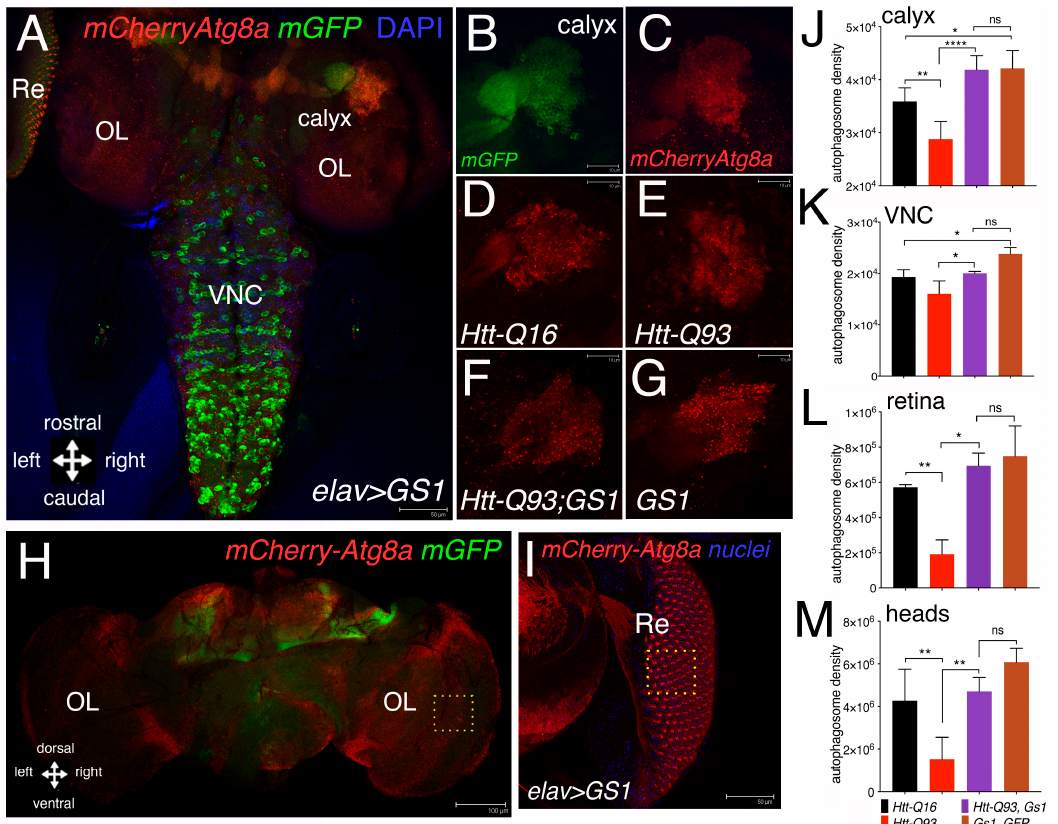
Figure 4. Expression of GS1 in neurons induces autophagy. ( A ) Confocal image of whole the brain from a third instar larva showing the pattern of expression for elav-mCherryAtg8a; GFP where the autophagic puncta are marked in red and neurons by GFP; the images represent the pattern of expression of elav-mCherryAtg8a from animals expressing UAS-GS1 . ( B , C ) Insets showing a higher magnification of the right calyx from A; neurons are visualized by elav-GFP. ( B ) and autophagic puncta by elav - mCherryAtg8a ( C ); bar 10 µm. Autophagic puncta were analyzed in the region of the calyx ( D–G ), retina (Re) ( I ) and in the Ventral Nerve Cord (VNC); OL = optic lobe. ( D – G ) representative images showing mCherryAtg8a staining in the calyx of the animals at the indicated genotypes, (a higher magnification of these images is shown in Supplementary Figure S10). ( H ) Image of an elav-mCherry-Atg8a; mGFP female’s head at 10 DAE; OL = optic lobe; bar 100 µm. ( I ) Image of an eye disc from a third instar elav-GS1 larva co-expressing mCherry- Atg8a in neurons of the retina and in the pigmented cells, with the nuclei stained in blue; bar 50 µm. ( J – M ) Quantification of autophagy was measured as the integrated density of mCherry-Atg8a and then converted in autophagosome density (see methods). Autophagosome density in neurons of the calyx ( J ), in the Ventral Nerve Cord (VNC), ( K ) in the retina ( L ), and in the adult heads ( M ) from animals of the indicated genotypes. One-way ANOVA p -values analysis: **** p < 0.0001, ** p < 0.01, * p < 0.05 were calculated from a minimum of five animals, error bars indicate the standard deviations.